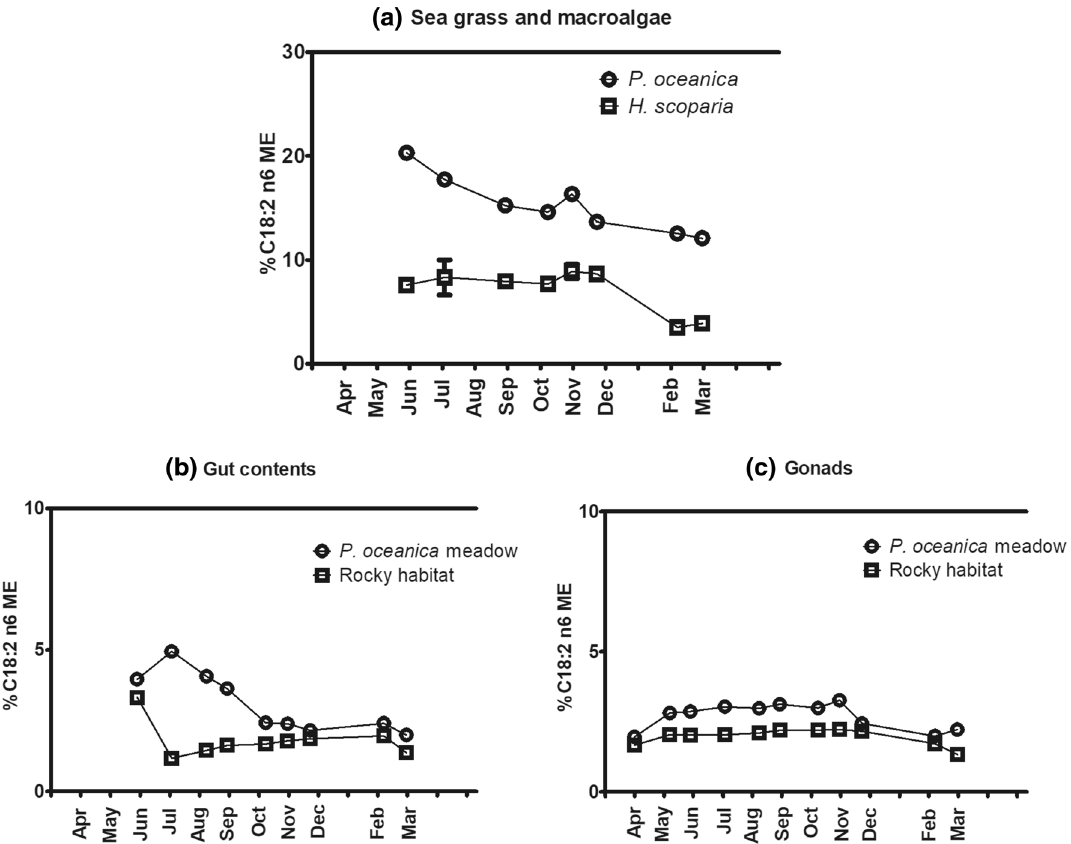
Figure 5. Seasonal effect on C 18:2 (n-6) contents in sea grass and macroalgae ( a ), gut contents ( b ) and gonads ( c ) of P. lividus from the two sites ( P. oceanica meadow and rocky bottom). Each point corresponds to the analysis of a pooled sample, as detailed in “Materials and methods”